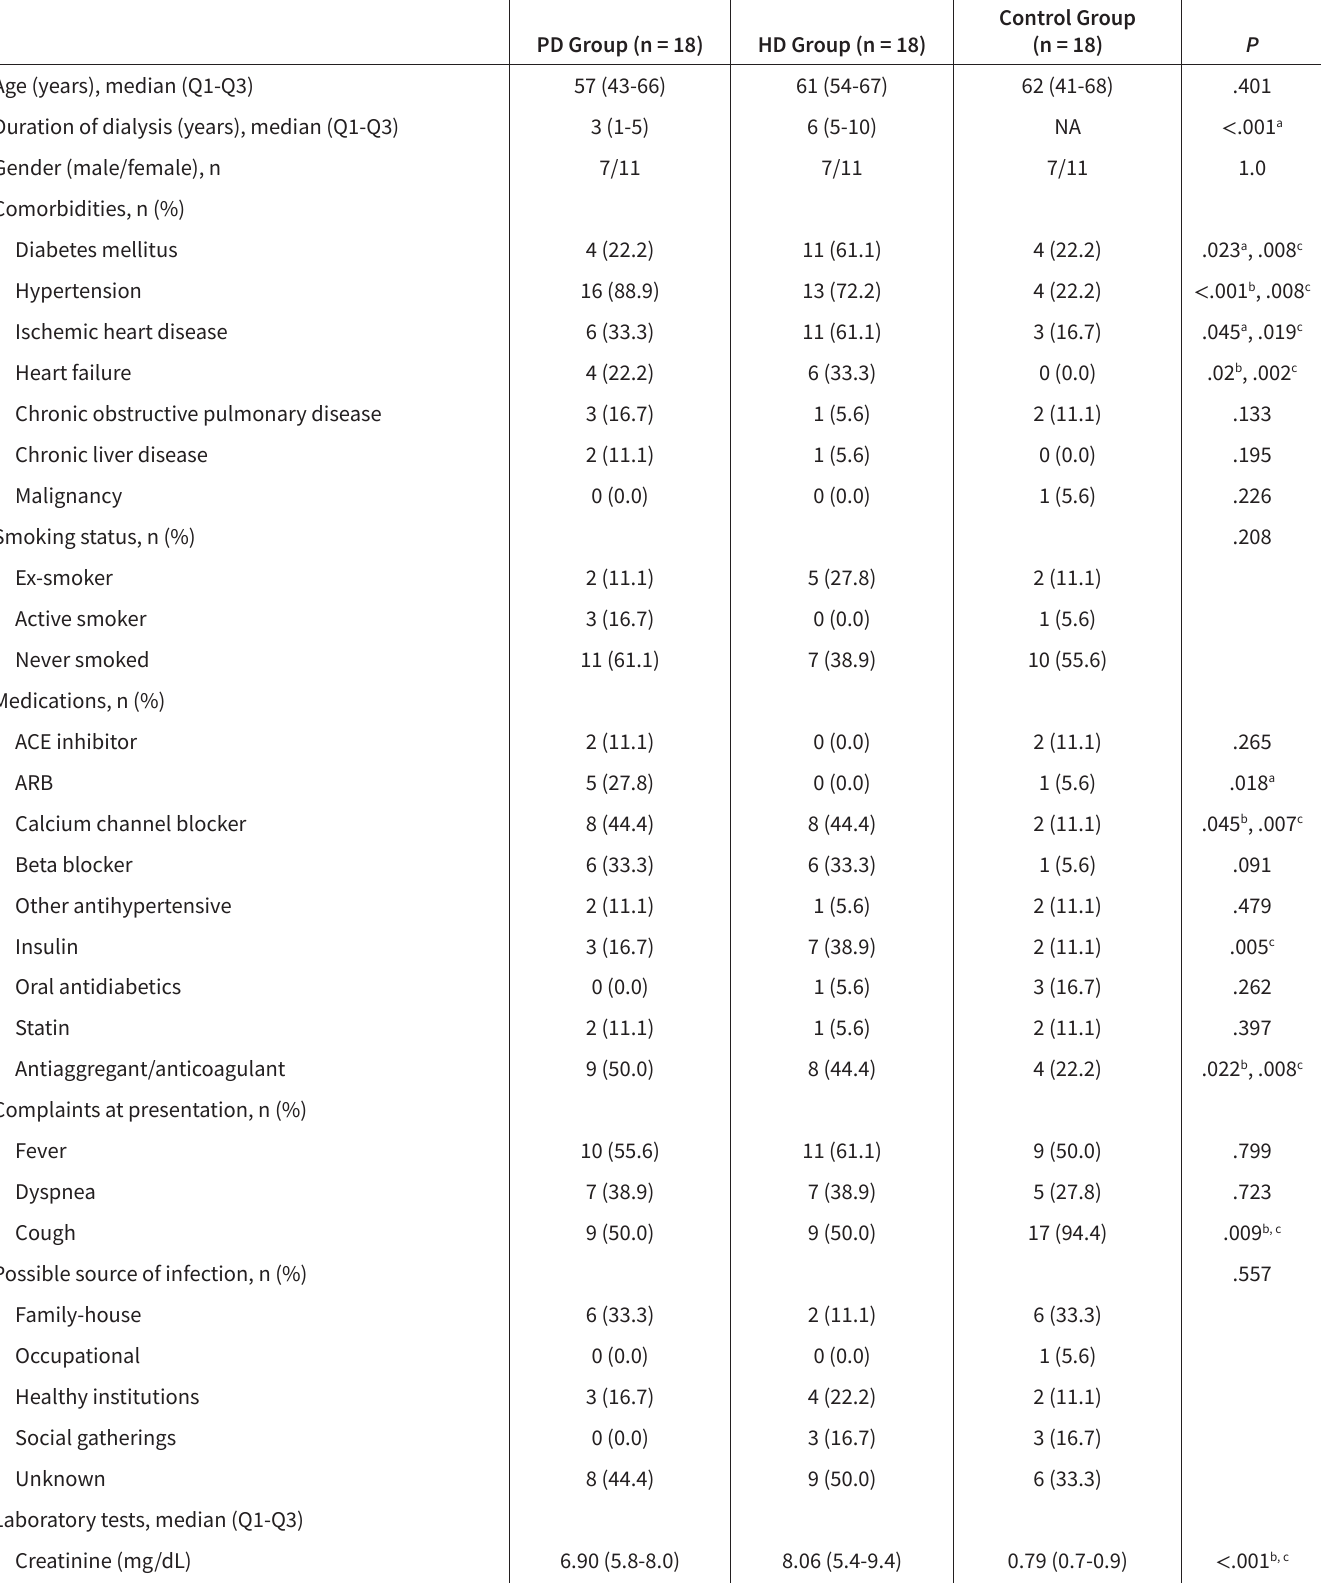
Table 1. Demographic Data, Comorbidities, Medications, Symptoms at Presentation, Possible Source of Infection and Diagnostic Methods, and Laboratory Data at the Time of Hospitalization and During Follow-Up Control Group PD Group (n = 18) HD Group (n = 18) (n = 18) P Age (years), median (Q1-Q3) 57 (43-66)